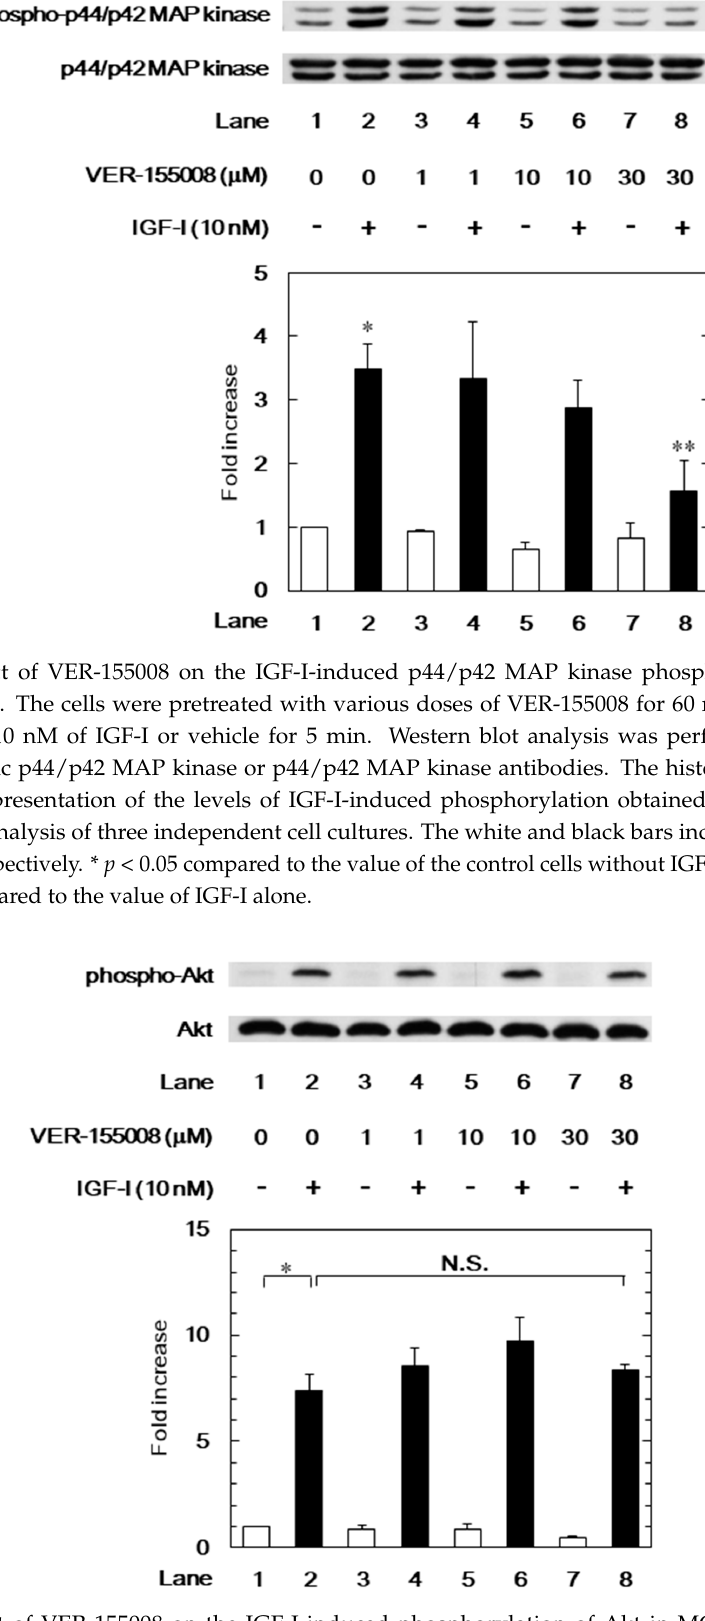
Figure 6. Effect of VER-155008 on the IGF-I-induced phosphorylation of Akt in MC3T3-E1 cells. The cells were pretreated with various doses of VER-155008 for 60 min and then stimulated by 10